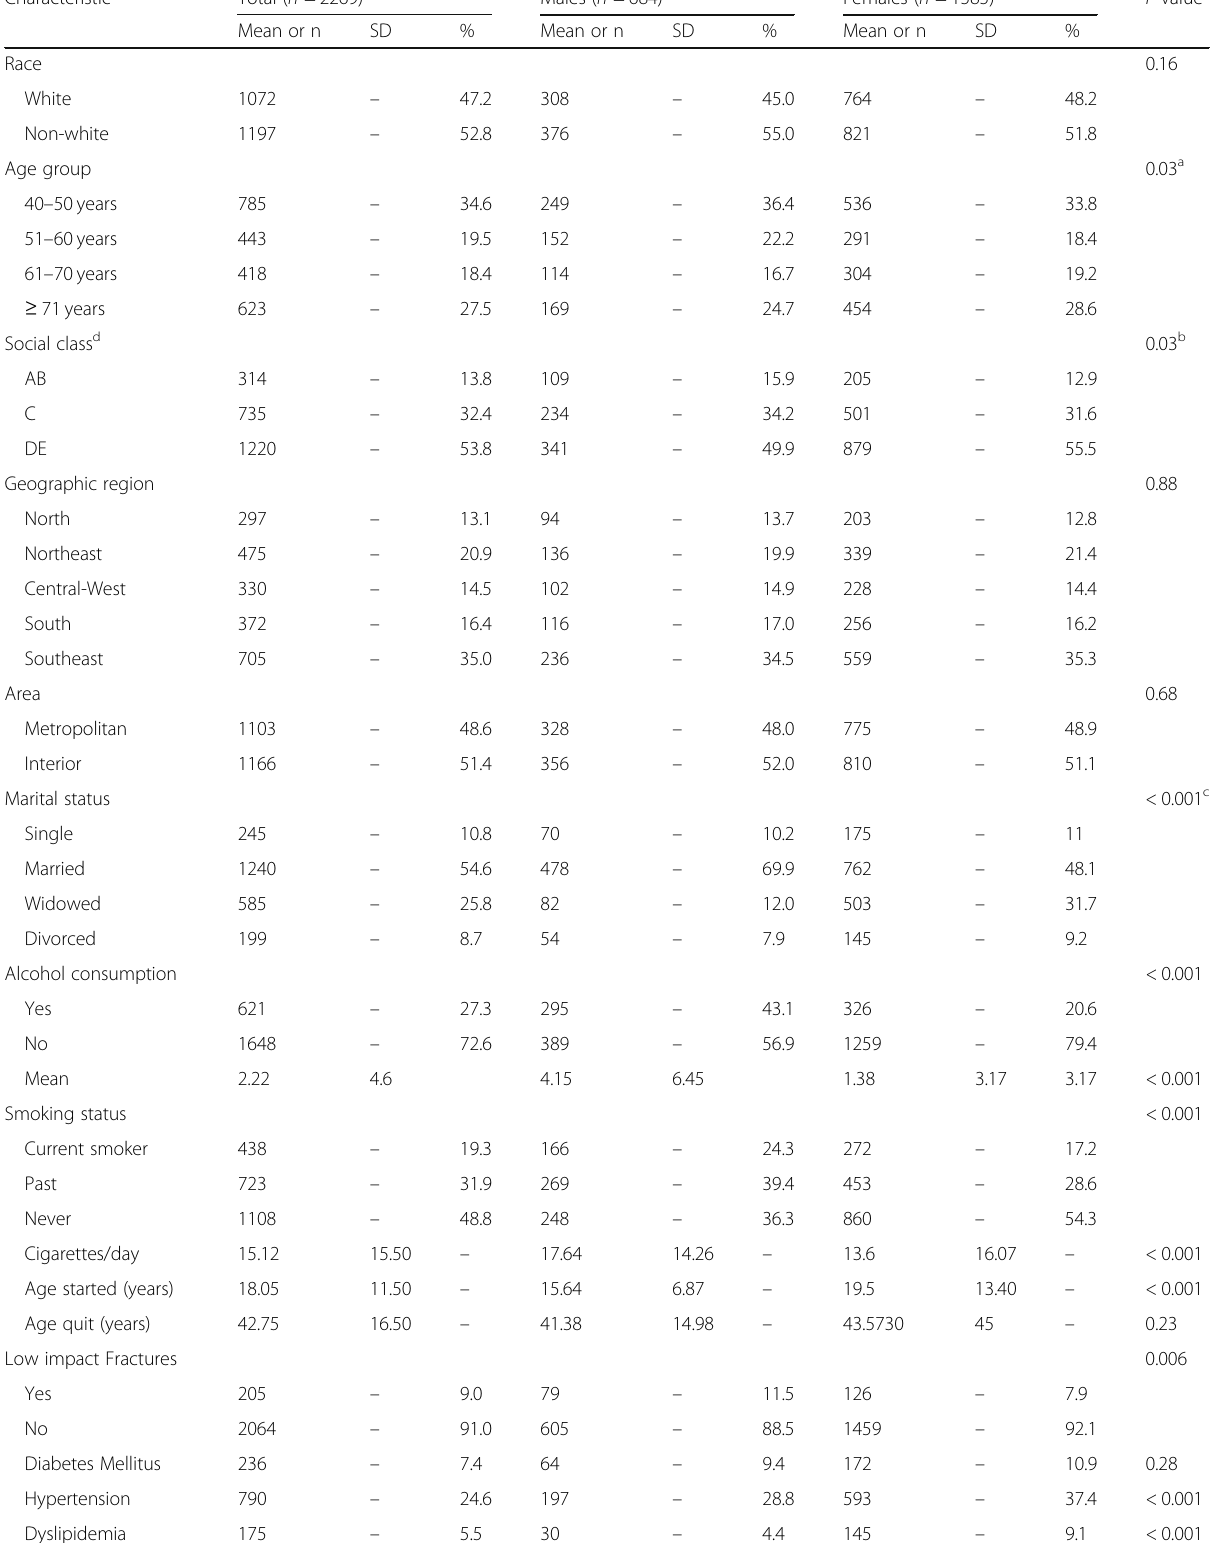
Table 1 Demographic and clinical characteristics of the participants – The Brazilian Osteoporosis Study Characteristic Race